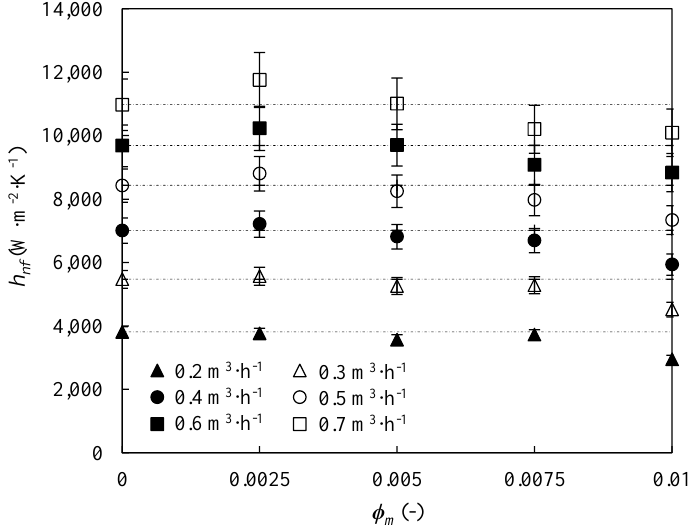
Figure 4. Experimental convection heat transfer coefficients, h nf , the nanoenhanced coolant as a function of fGnP mass fraction, φ m , for 6 different volumetric flow rates at T nf = 318.15 K. Error bars indicate the expanded uncertainty (k = 2).